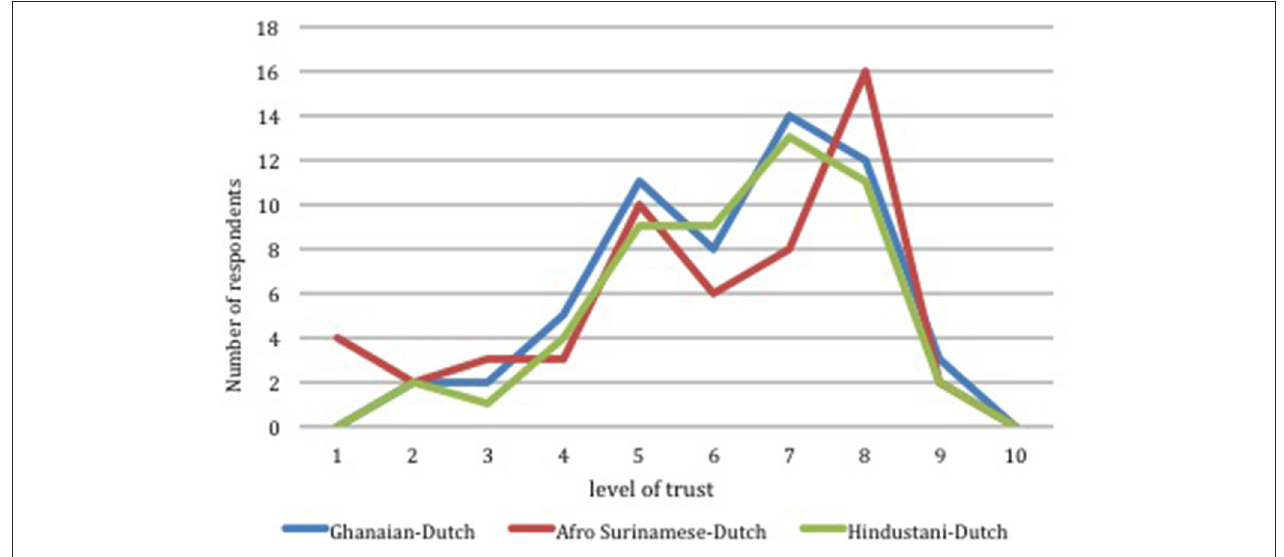
FIGURE 2 | Level of trust in the safety and effectiveness of COVID vaccines across 3 different ethnic groups in